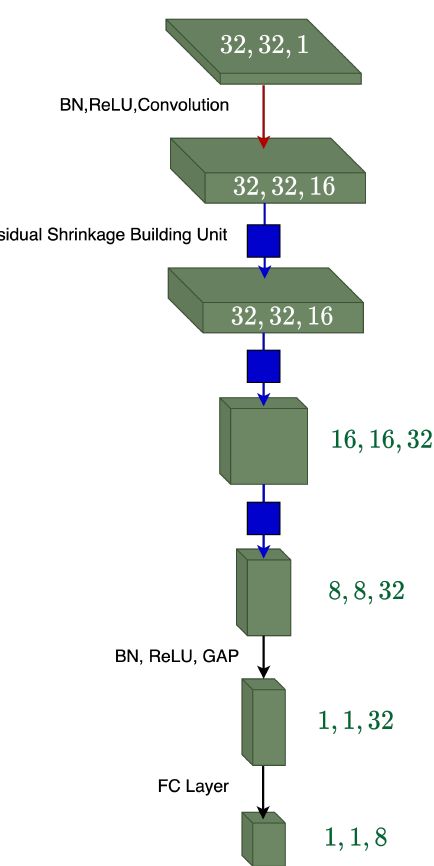
Figure 4. Overall deep residual shrinkage